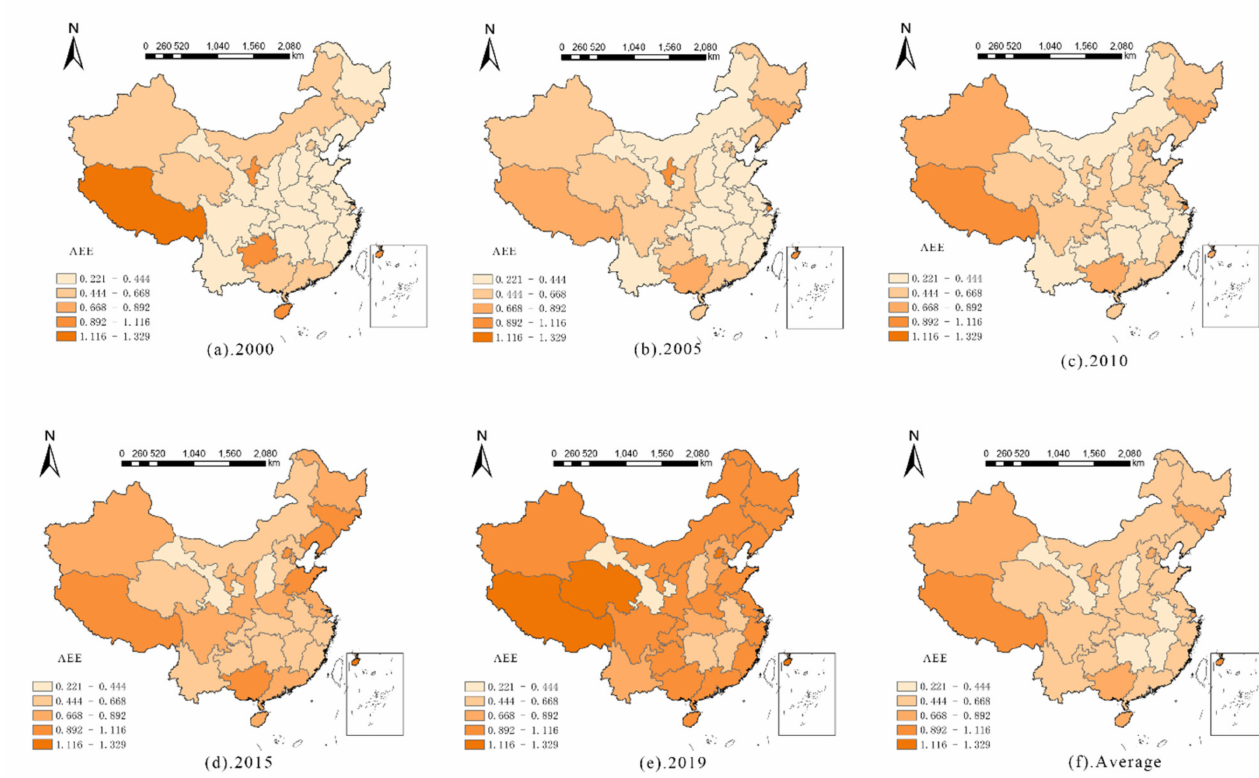
Figure 3. Spatial distribution of AEE every five years in